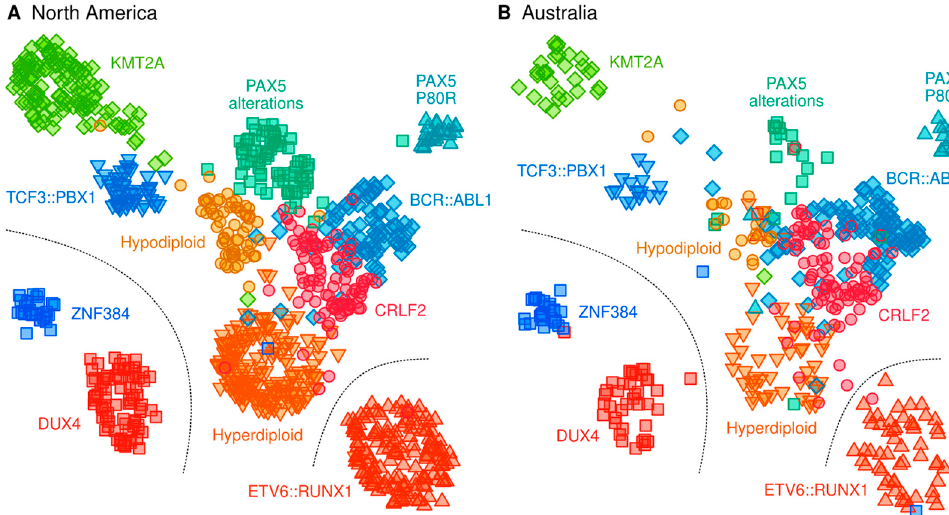
Figure 3. Transcriptional landscape of the most frequent ALL subtypes. Clustering structure in the North American data was modeled by the Uniform Manifold Approximation and Projection (UMAP) algorithm and using the same genes that were prioritized and pre-processed for the cen- troid classifier. ( A ) Standardized but unadjusted gene expression values were used for re-projecting the North American samples onto the UMAP layout. We use the unadjusted expression profiles here since, in practical settings where patients arrive one-by-one, adjustments for batch effects that would be available in research settings cannot be made. ( B ) Unadjusted Australian data were projected onto the same UMAP layout as an independent external validation set.